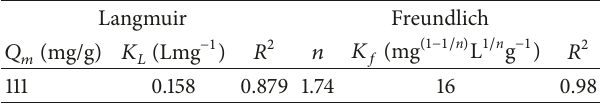
Table 2: Parameters of Langmuir and Freundlich adsorption isotherm models of